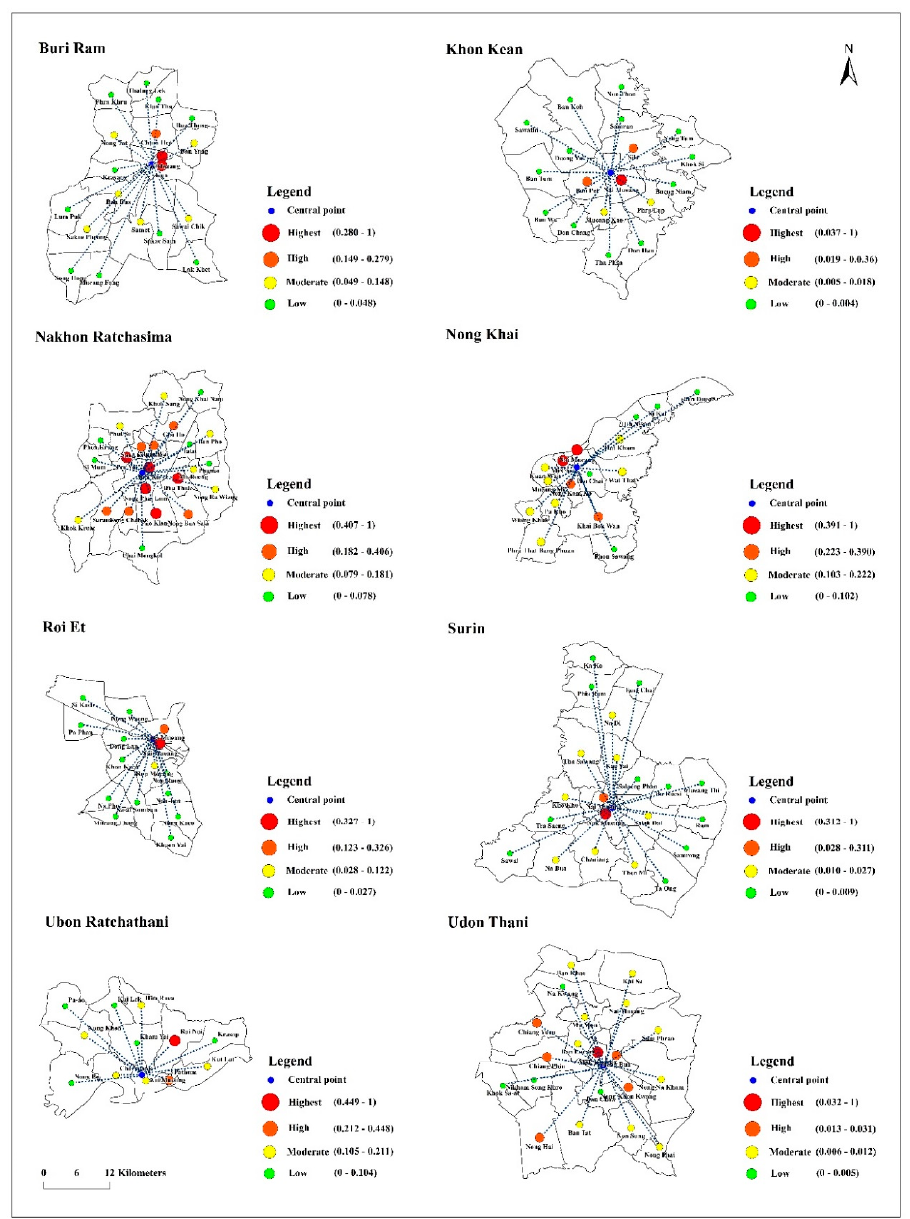
Figure 5. Sub-district location around the central point of service based on gravity index spatial interaction.